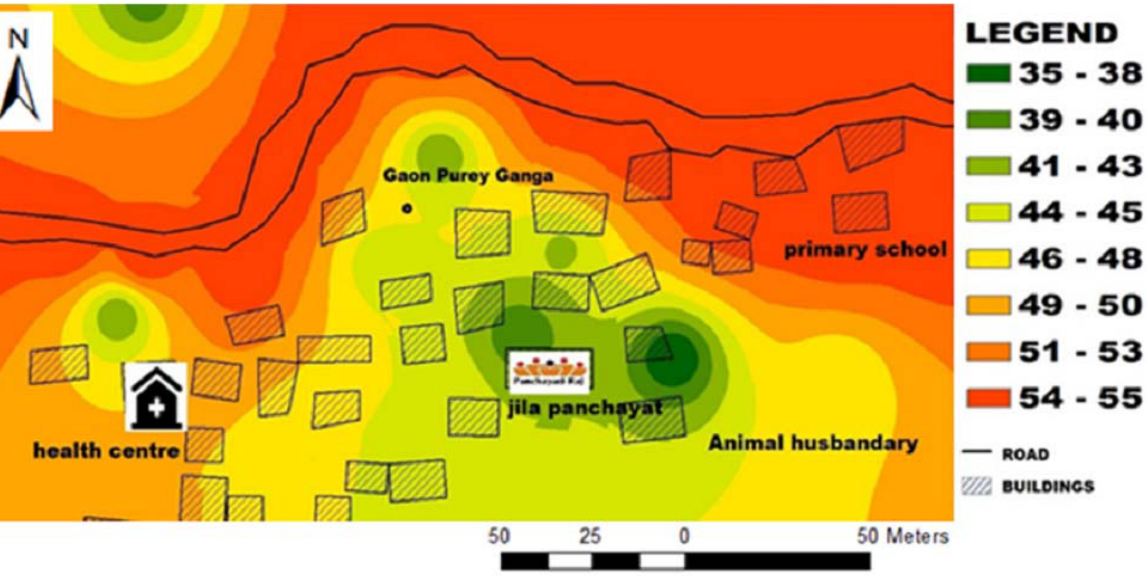
Figure 23. Noise exposures map for short duration at noise value 90 dB in event wise at time 5:00–6:30 p.m.